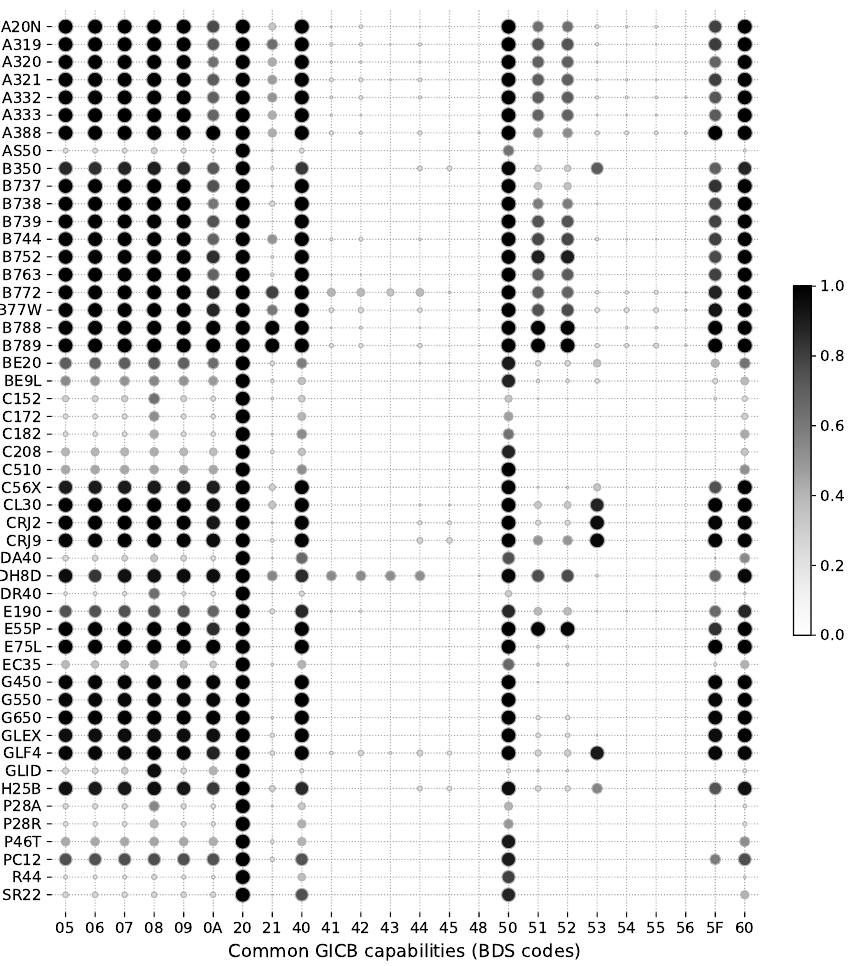
Figure 3. GICB capabilities of the top 50 aircraft types. Darkness and size of a dot represent the fraction of aircraft that have a certain capability